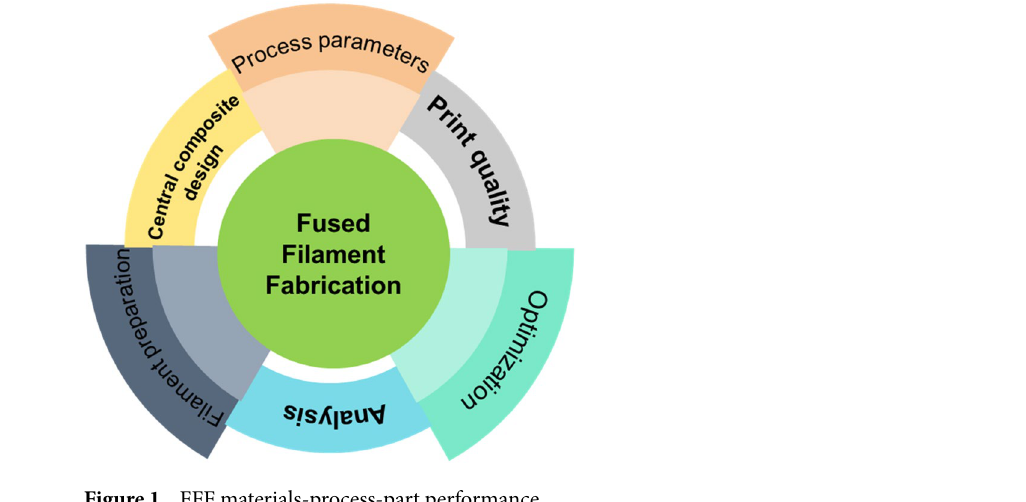
Figure 1. FFF materials-process-part